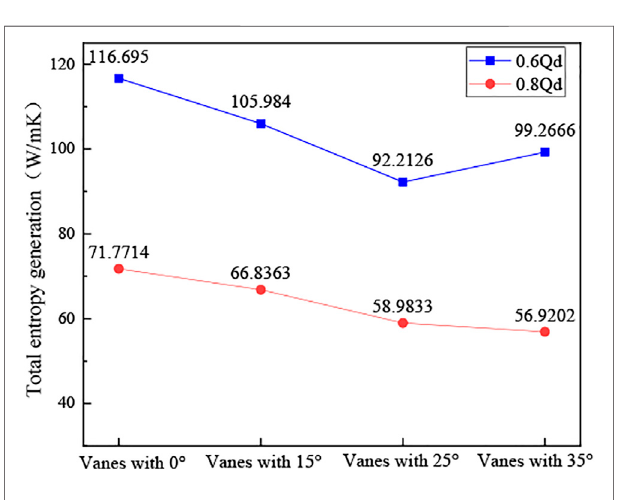
FIGURE 10 | Entropygeneration rateat0.6 Q d and 0.8 Q d operatingpoints.